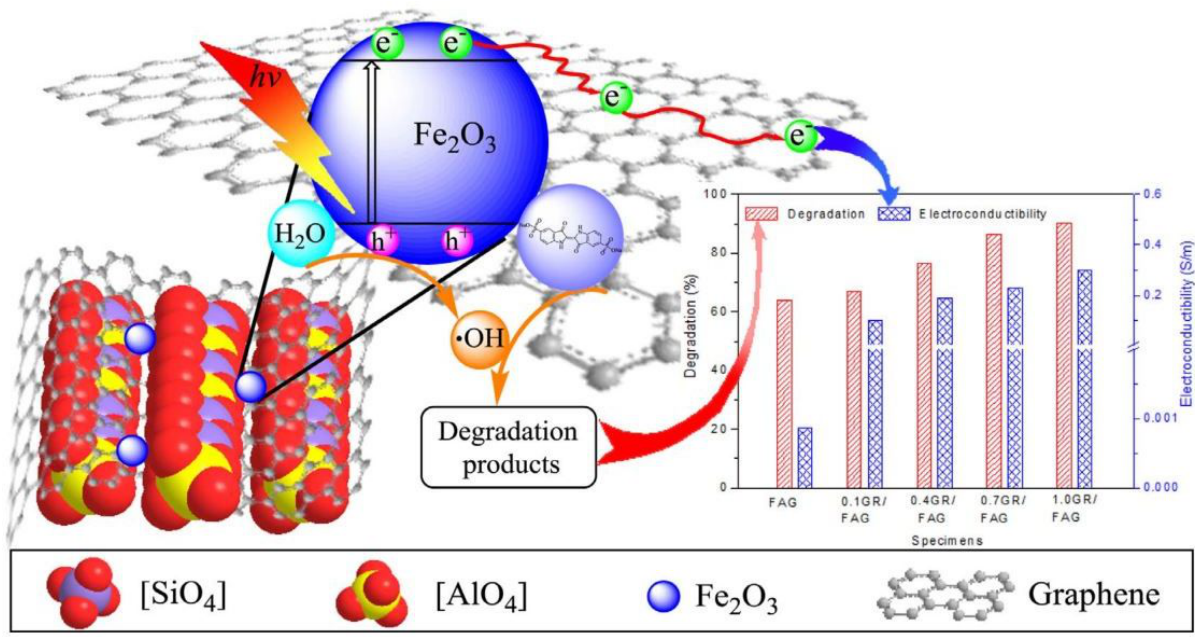
Figure 8: Schematic mechanism of the photocatalytic degradation of indigo carmine over an electroconductive GR/FAG composite